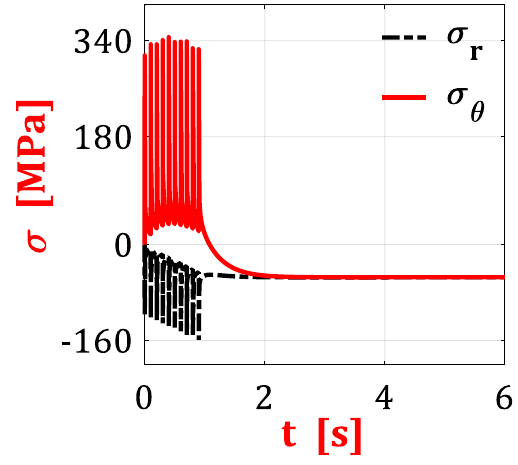
Fig. 16 Stresses-time history at the mid- radial section of the tem- perature-dependent thick-walled cylinder due to 10 cycles in 6 s